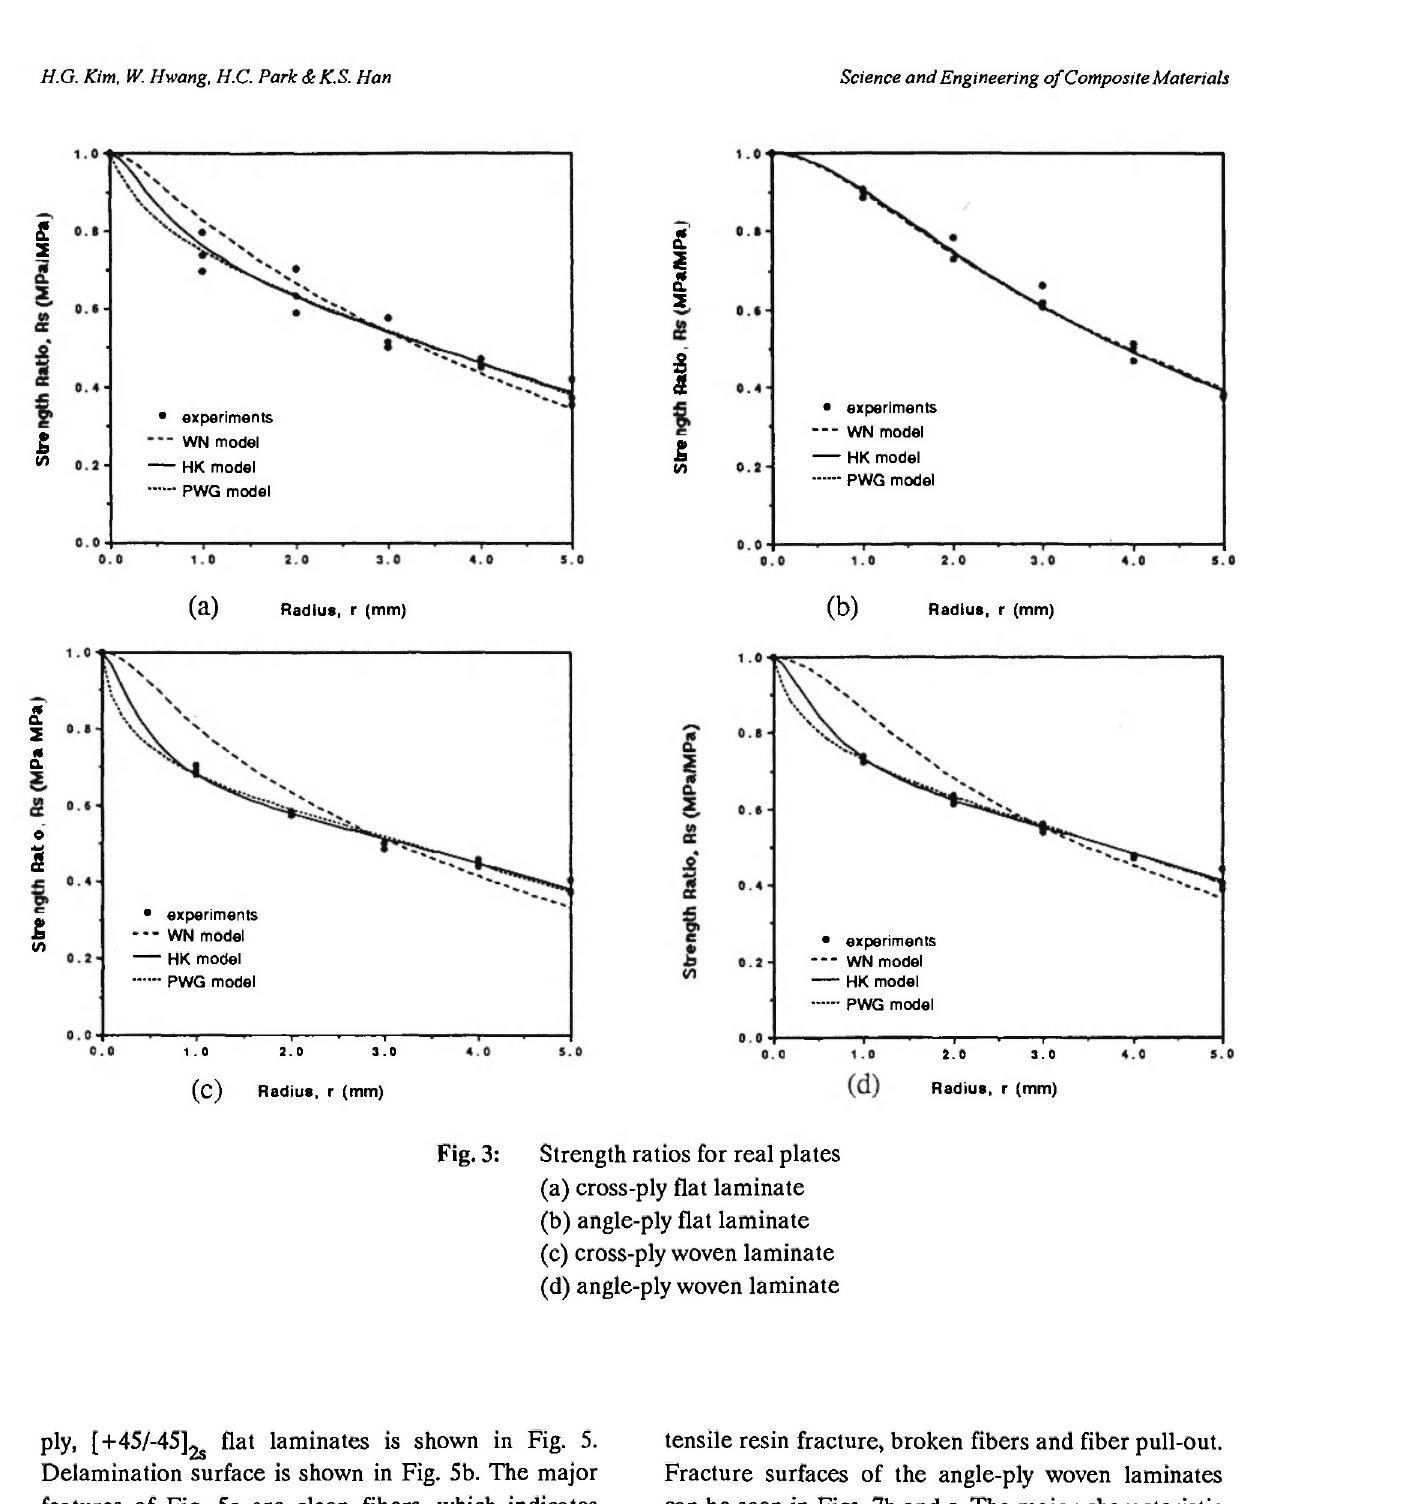
tensile resin fracture, broken fibers and fiber pull-out. Fracture surfaces of the angle-ply woven laminates can be seen in Figs. 7b and c. The major characteristic features are matrix residue on fiber surface, hackle markings and fiber break which are not observed in the angle-ply flat